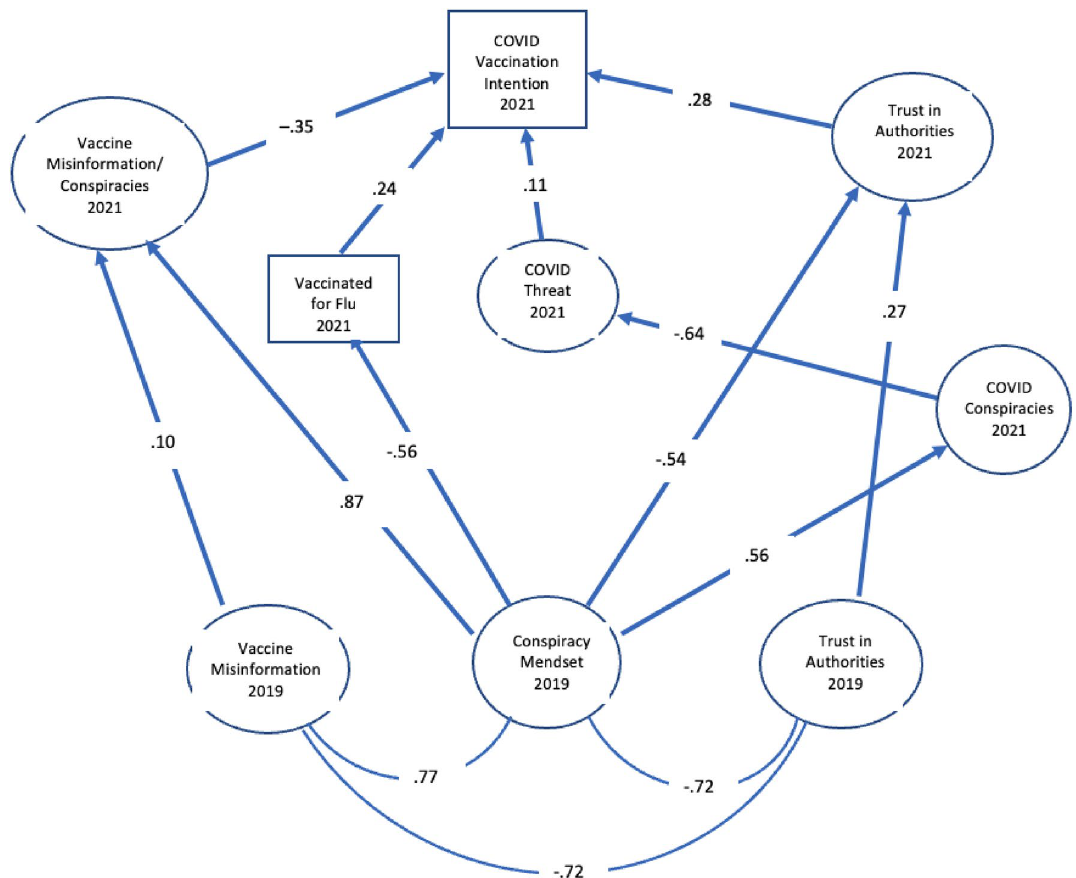
Figure 2. Structural relations in main